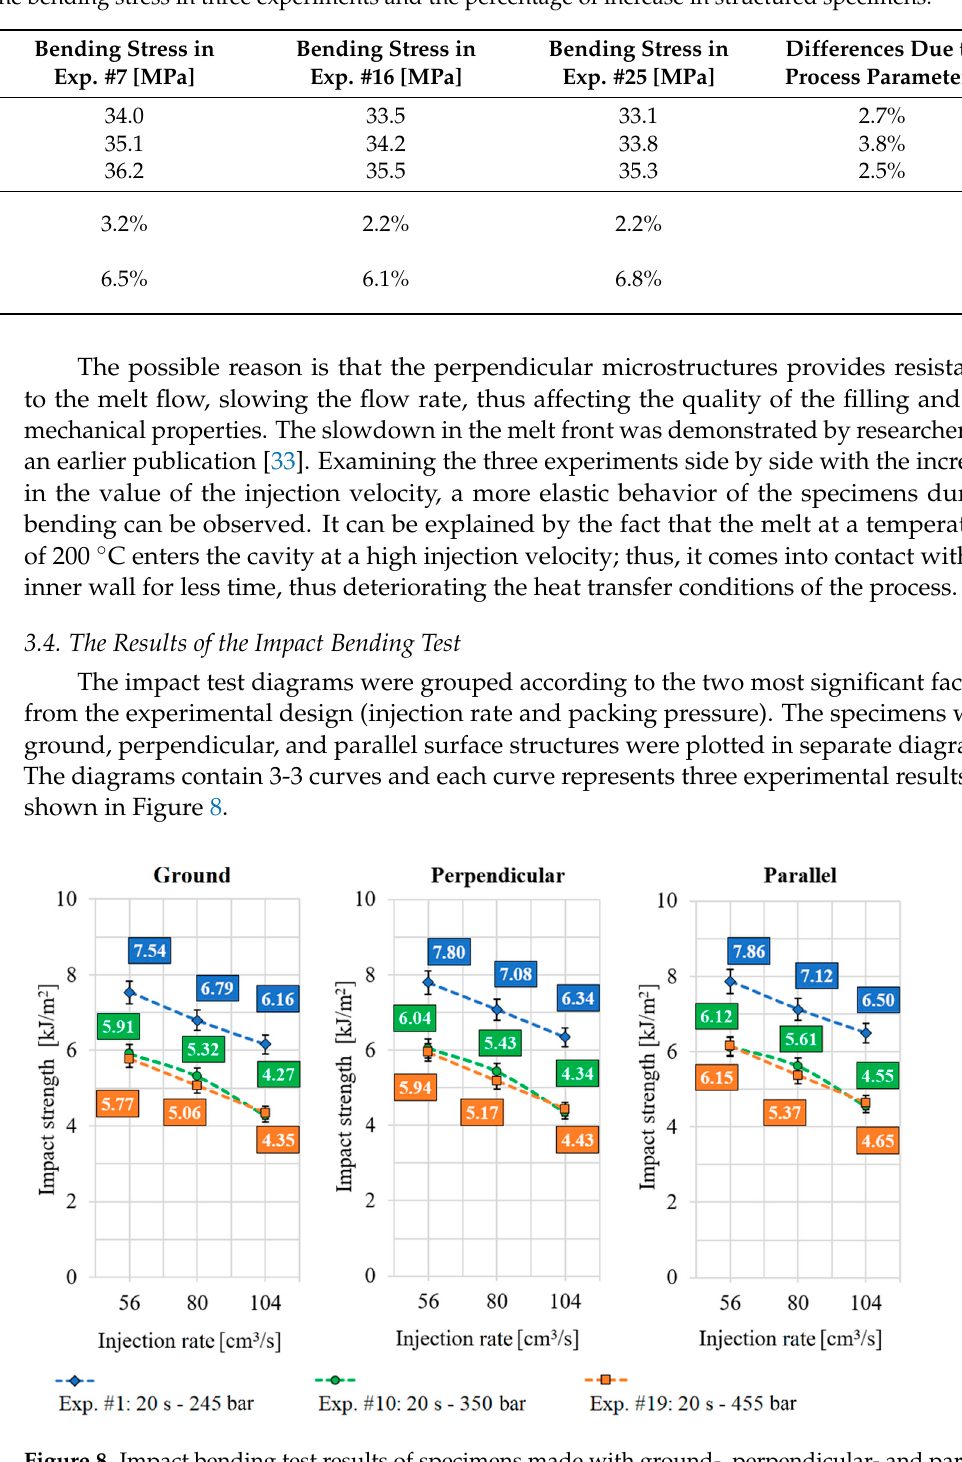
Figure 8. Impact bending test results of specimens made with ground-, perpendicular- and parallel surface-structured inserts.